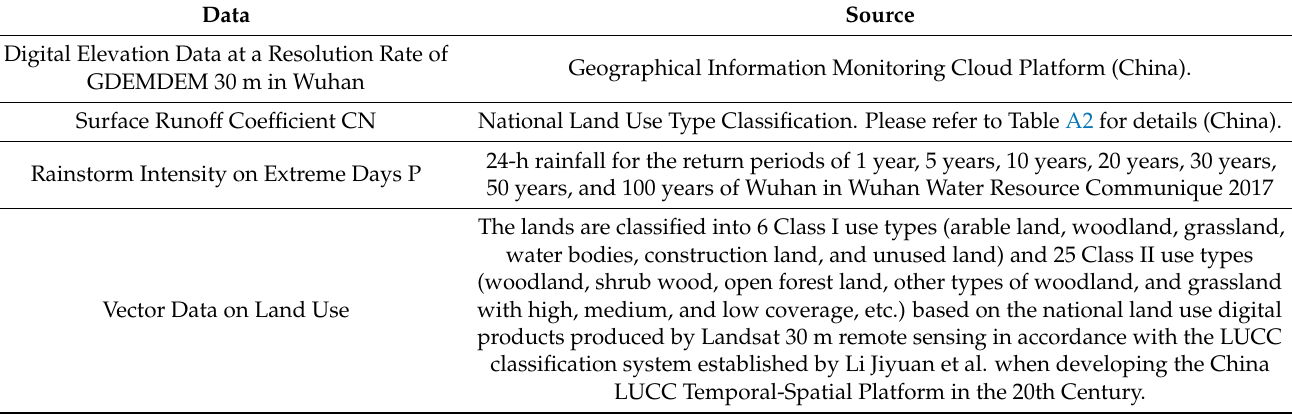
Table A1. Data sources of water collection capacity experiment.